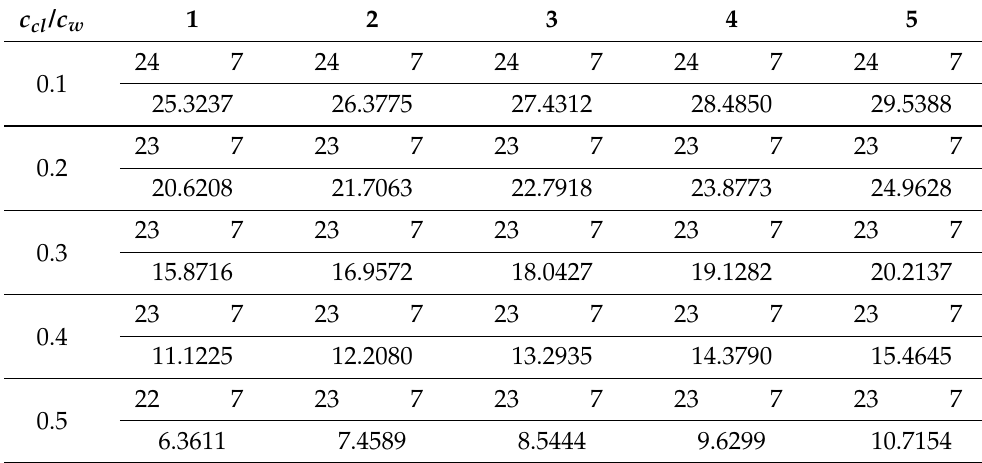
Table 3. Ramification of the cost rate of a lost customer during the stock out period ( c cl ) and cost rate of waiting customer in the pool ( c w ) on the optimal values.